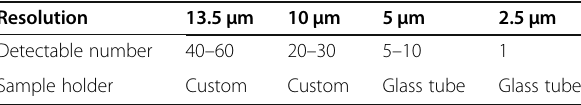
Table 3 Resolution of micro-CT and the detectable number of rice